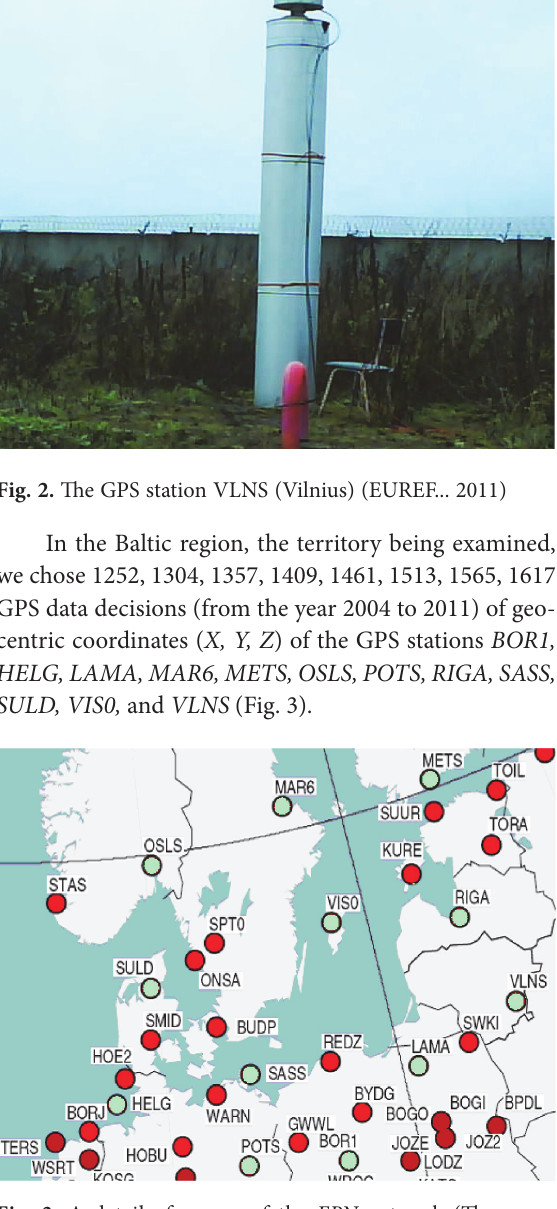
Fig. 3. A detail of a map of the EPN network (The green points – the stations of the EUREF GPS network used in the research, the red points – the stations of the EUREF GPS network not used in the research) (EUREF... 2011)